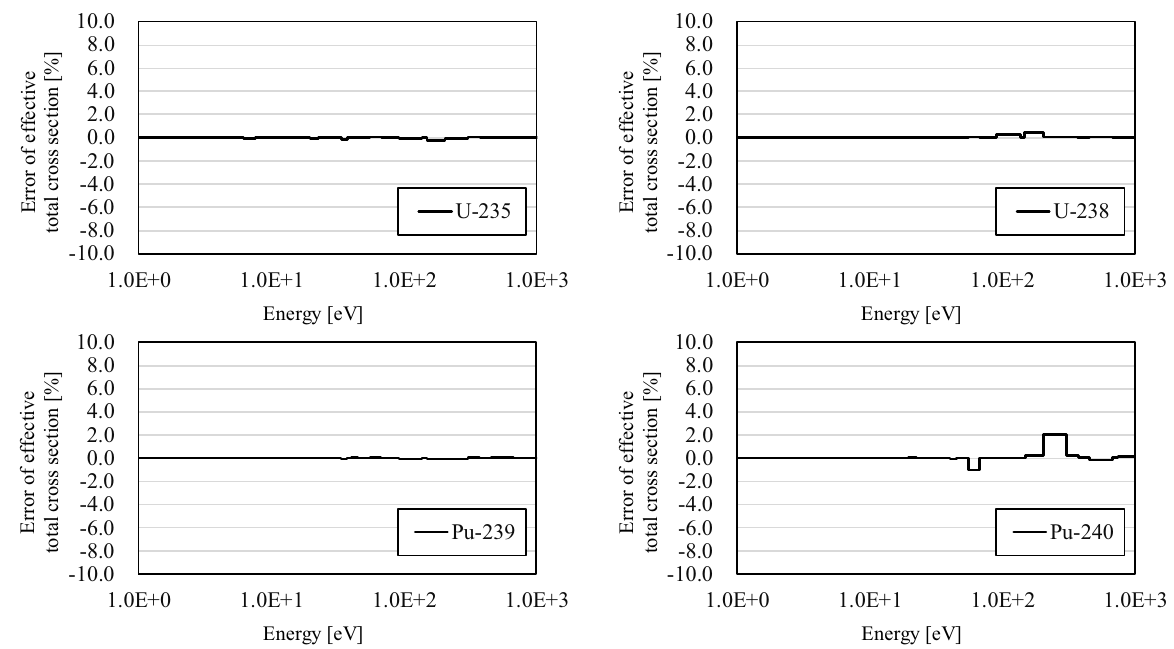
Figure 6. Error of effective total cross sections of U-235, U-238, Pu-239, and Pu-240 in MOX of Fig.